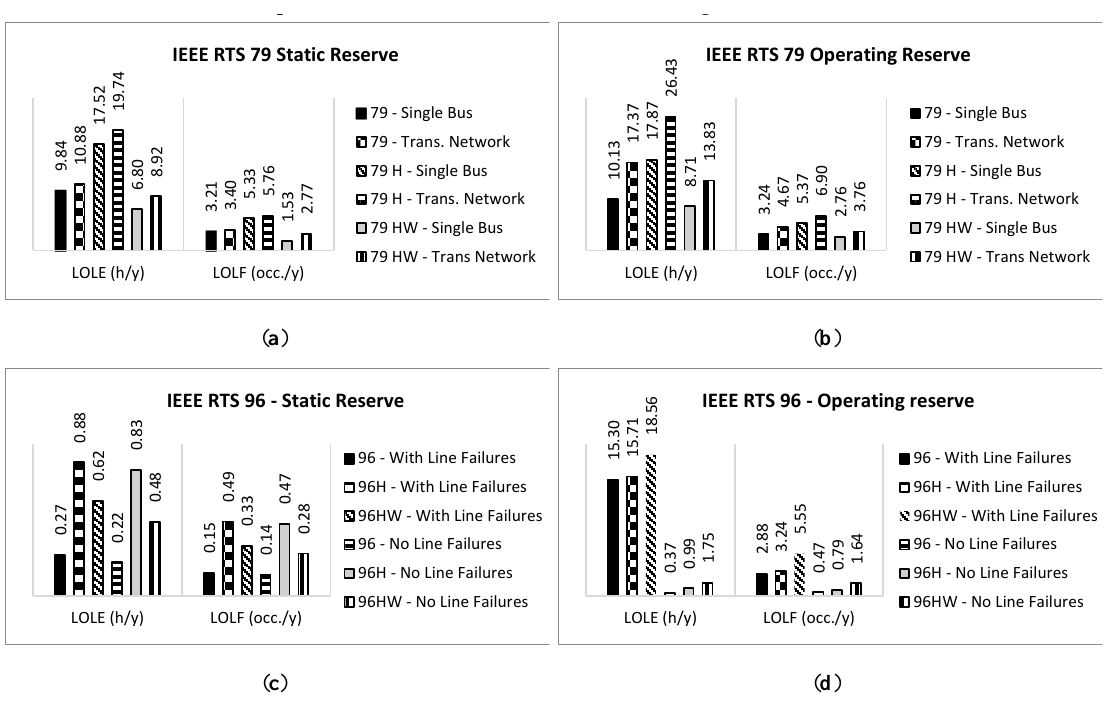
Figure 4. Results for different system representations and wind energetic model. ( a ) IEEE RTS 79 Static Reserve; ( b ) IEEE RTS 79 Operating Reserve; ( c ) IEEE RTS 96 Static Reserve; ( d ) IEEE RTS 96 Operating Reserve.